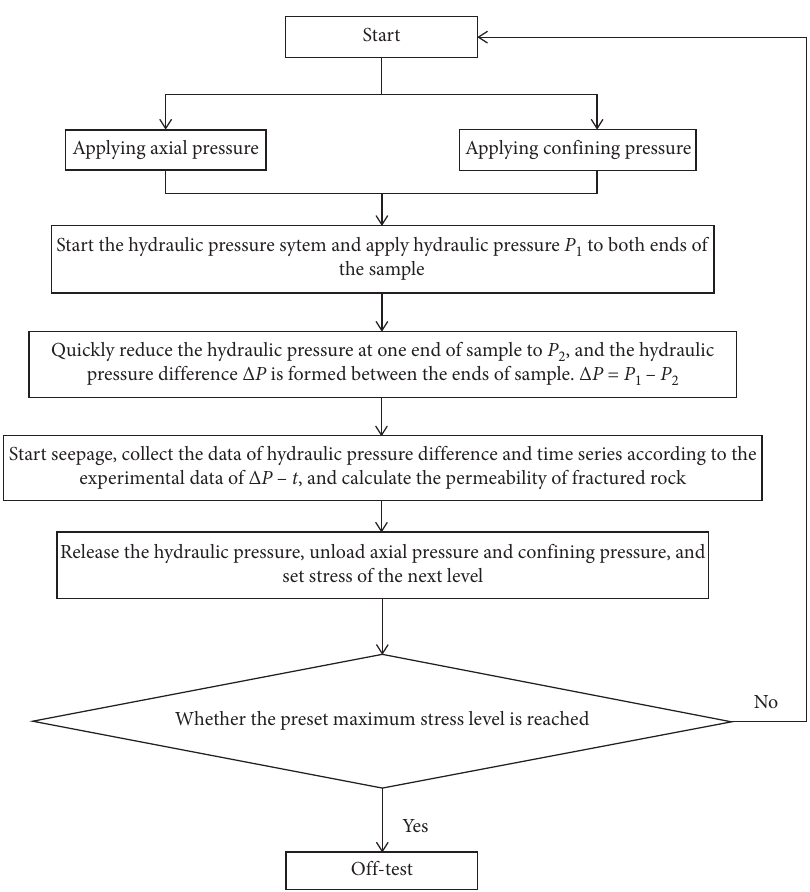
Figure 4: Flowchart of seepage test of fractured rock under cyclic loading and